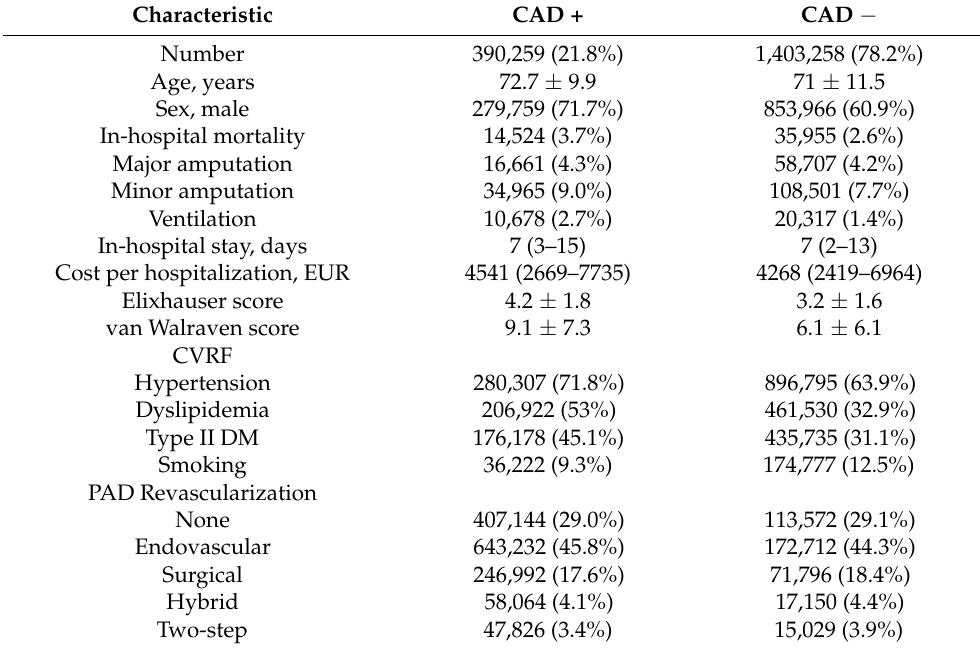
Table 1. General characteristics of patients admitted for peripheral artery disease with and without coronary artery disease between 2009 and 2018.